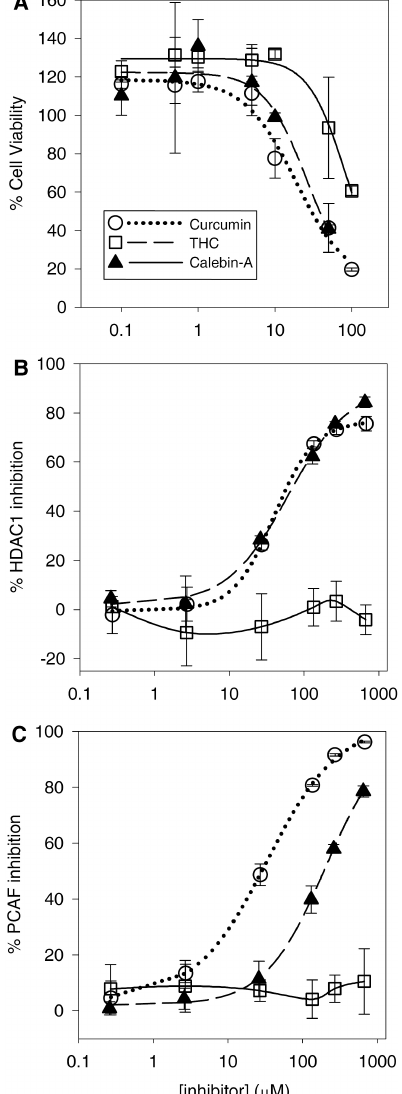
Figure 6. Cell viability and HDAC and HAT inhibition. The viability of Sup-T1 cells with increasing concentrations of the curcuminoids ( A ); the direct inhibition of the HAT PCAF by the curcuminoids as measured by an ELISA assay ( B ); the direct inhibition of the HDAC HDAC1 by the curcuminoids as measured by an ELISA assay ( C ). For each graph the points are the means of three values with an SD.